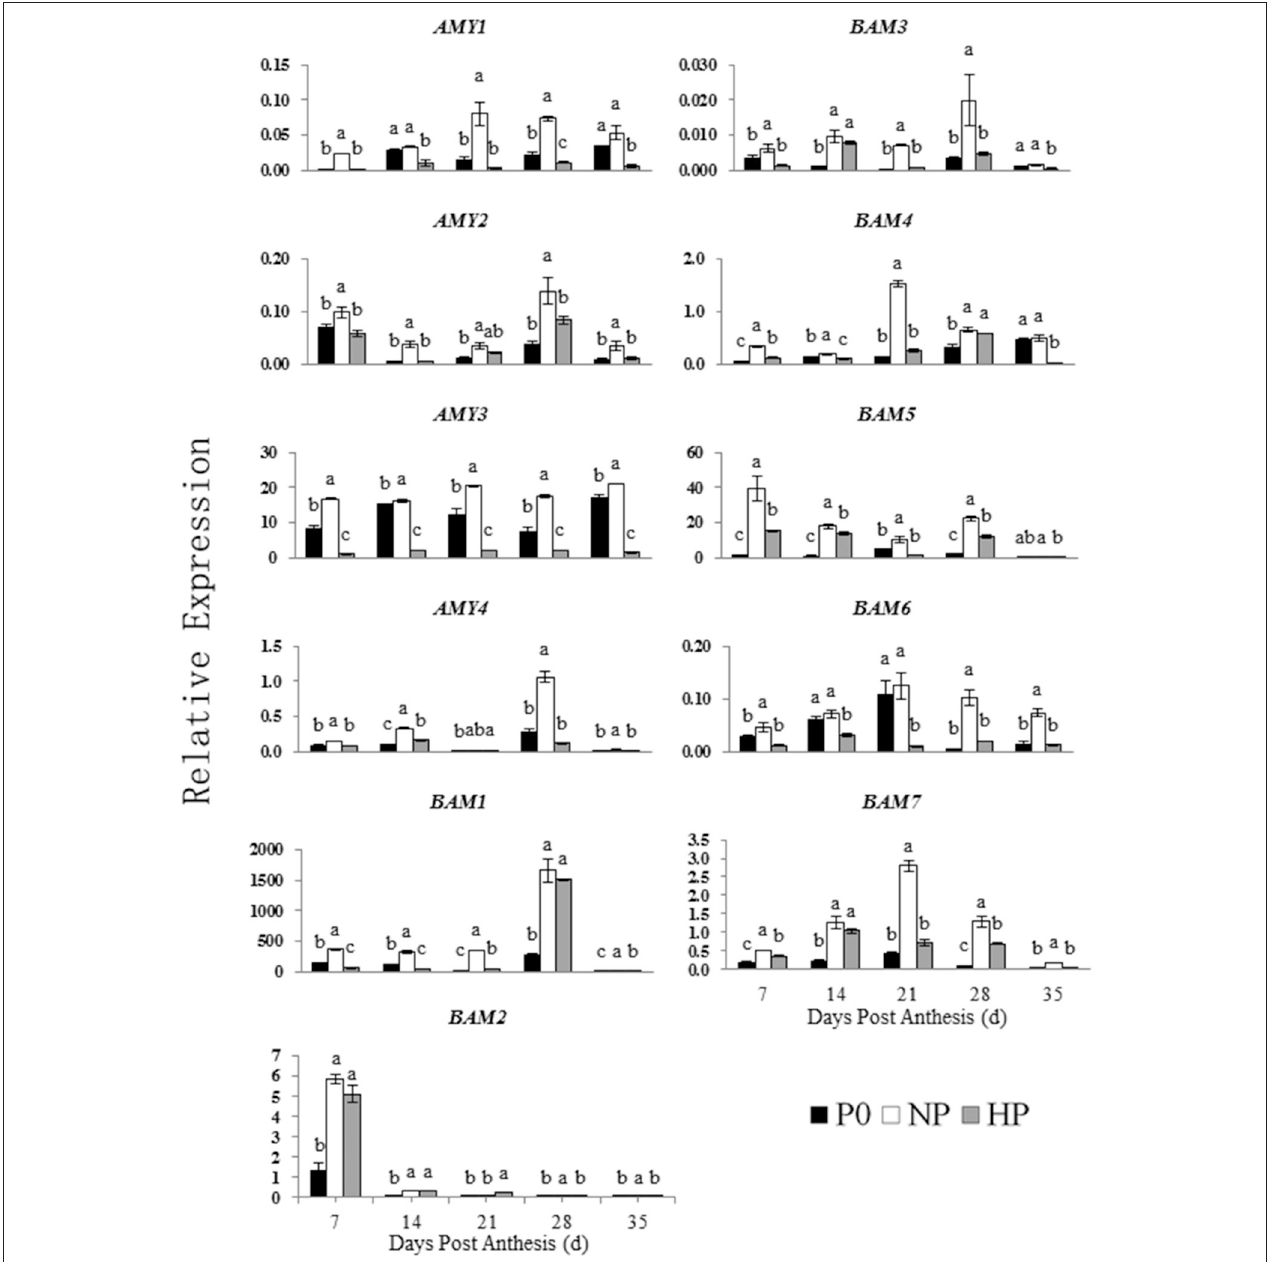
FIGURE 6 | Relative expression of genes involved in starch degradation in developing wheat endosperm. Values are means ± S.E. of three replications. Columns with different letters are significantly different at p < 0.05. P0: 0kg P ha − 1 ; NP: 46kg P ha − 1 ; HP: 92kg P ha − 1 .